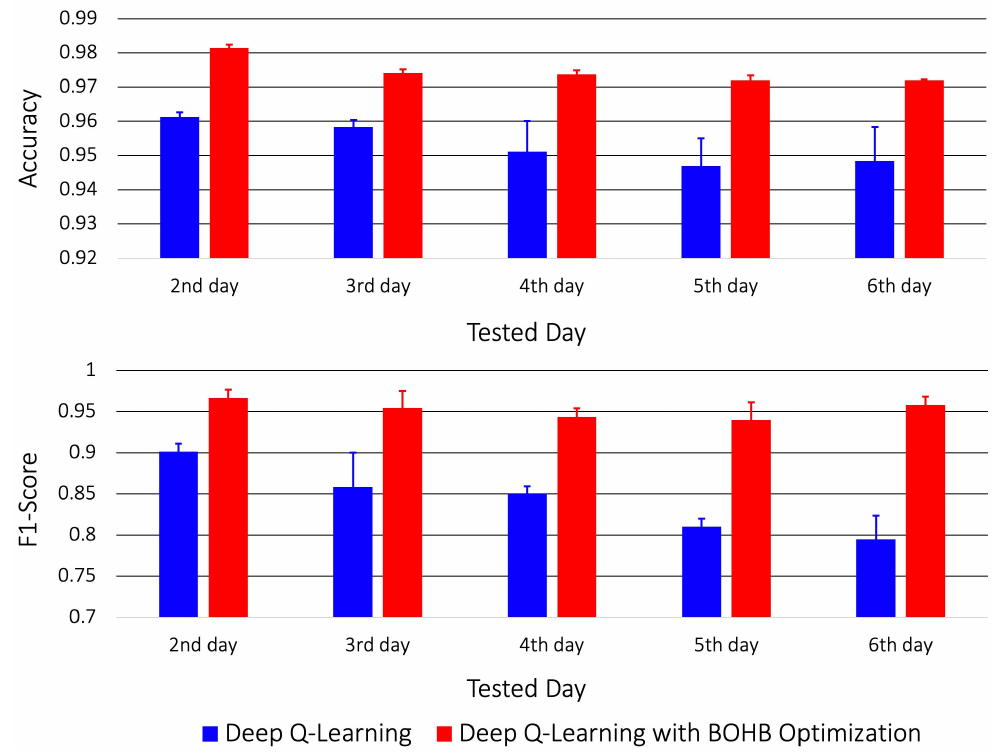
Figure 4. Testing results of RL based on the costly feature selection algorithm calculated using the accuracy ( upper ) and F1-score ( lower ) and plotted as a function of tested